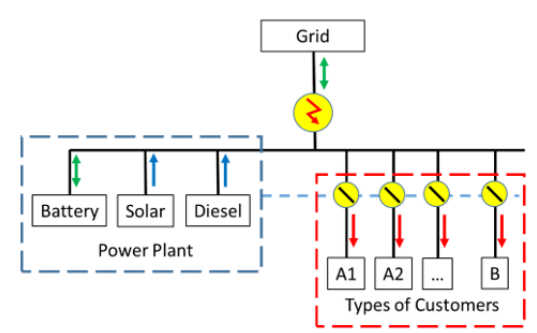
Figure 1. Configuration of an undergrid